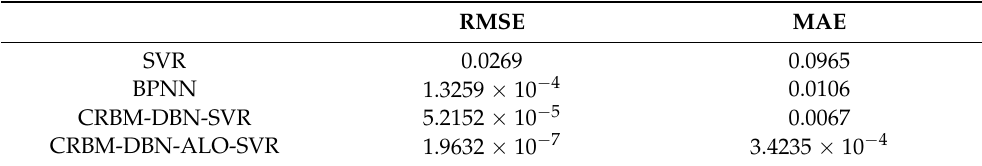
Table 2. Performance evaluations of different prediction